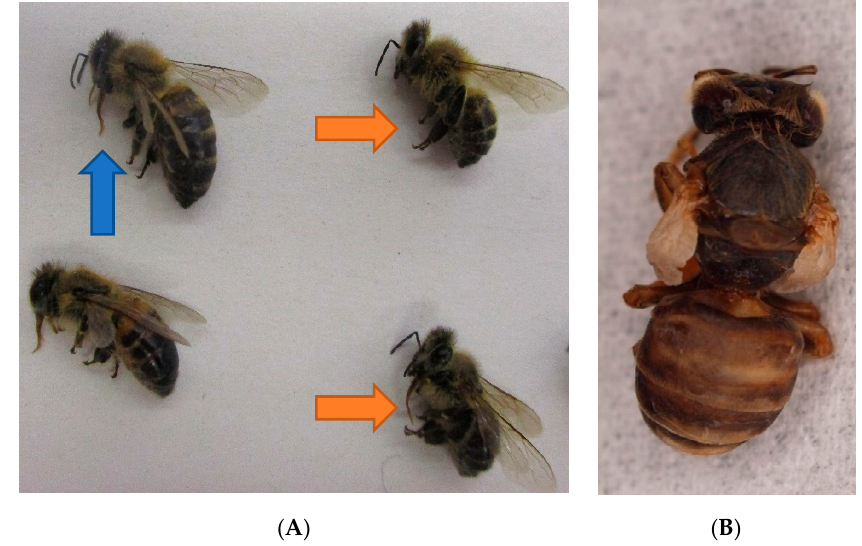
Figure 4. ( A ) sample of dead bees of a honeybee colony infected with CBPV in 2019: inhomogeneous size of worker bees, shortened abdomen (orange arrows), extended proboscis (blue arrow); © Julia Dittes. ( B ) freshly hatched honeybee infected by DWV; © Heike Aupperle-Lellbach.